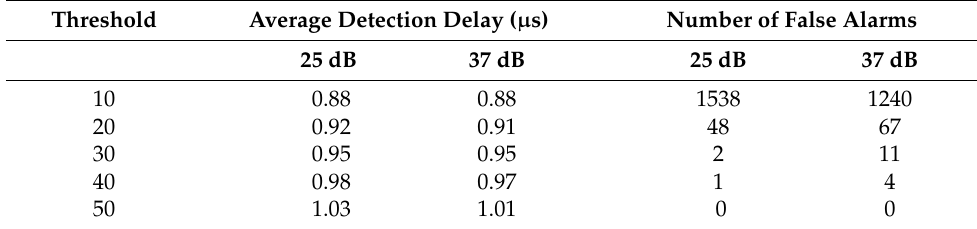
Table 2. Average detection delay and number of false alarms for different threshold